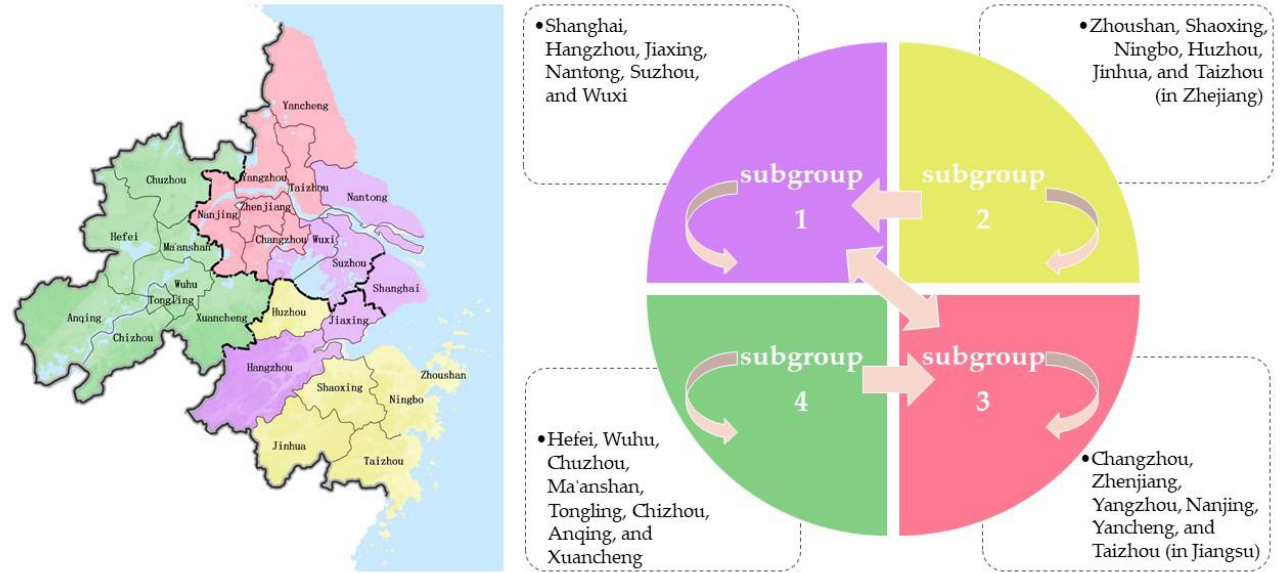
Figure 7. Spatial clustering analysis of CO 2 emissions in the YRDUA’s cities in 2018.